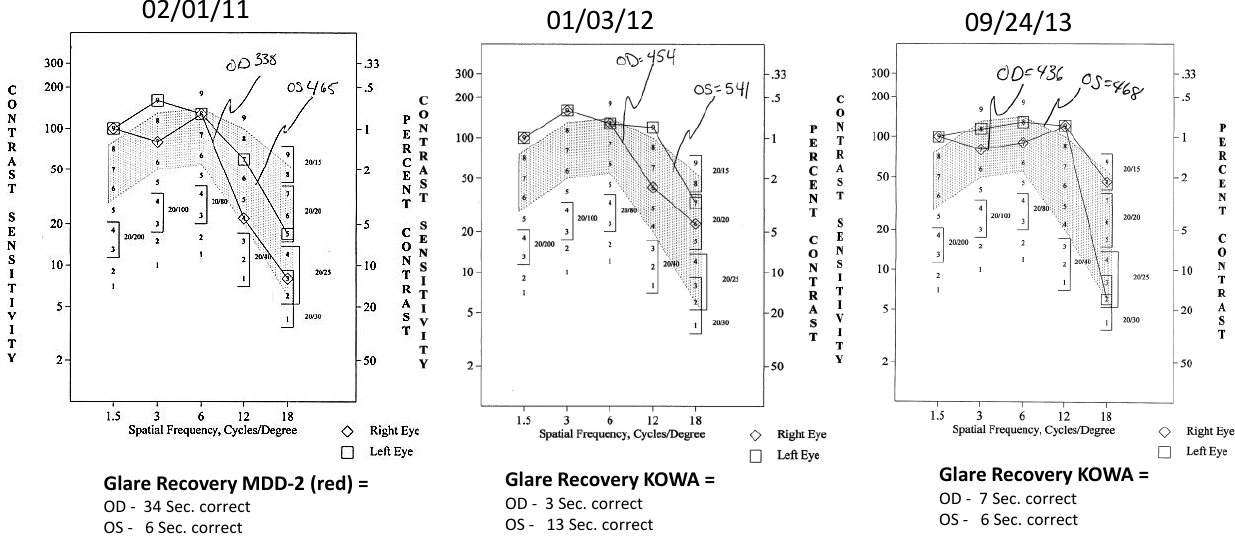
Figure 4. Contrast Sensitivity and Glare Recovery of a 64-year-old male patient with AMD and diabetes type 2. With time, approximately 2.5 years, comprehensive measures of visual function, such as contrast sensitivity, improve in both eyes while glare recovery to a photo stress stimulus improves in his left eye. This is opposite of the expected AMD related decline. Baseline Snellen visual acuity was 20/25 R, 20/20 L and further improved in the right eye to 20/20 by the second visit within one year.